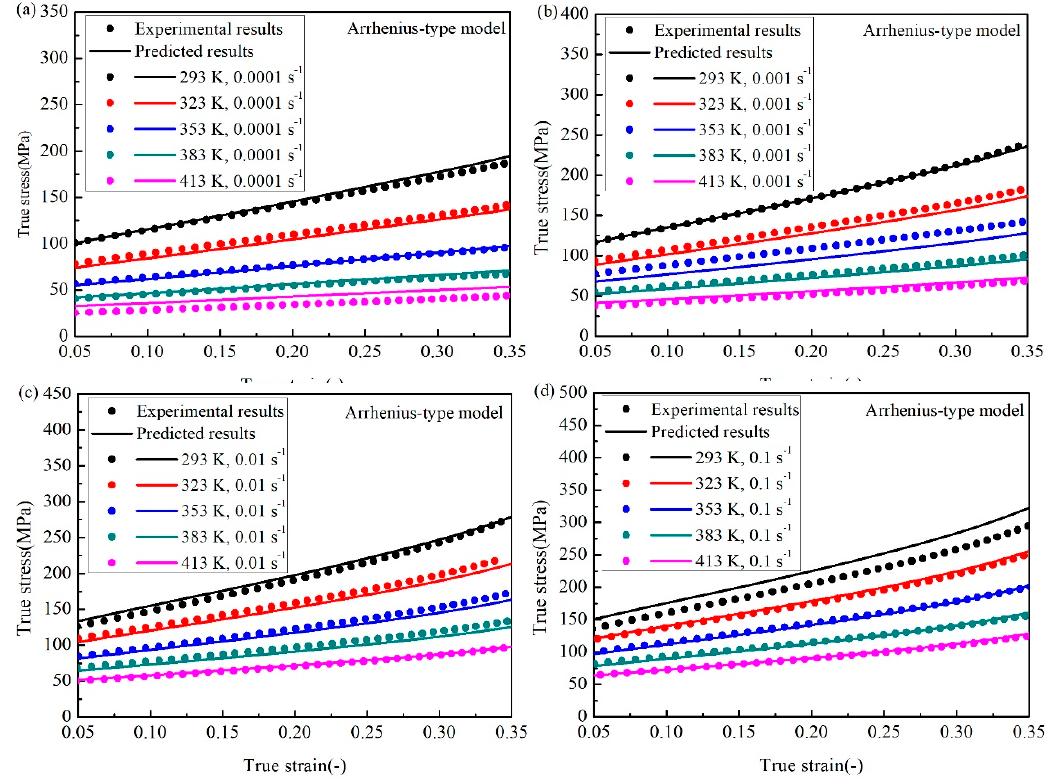
Figure 17. Comparison between the experimental data and predicted values by the A-type model at the strain rate of ( a ) 0.0001 s − 1 , ( b ) 0.001 s − 1 , ( c ) 0.01 s − 1 , and ( d ) 0.1 s − 1 .